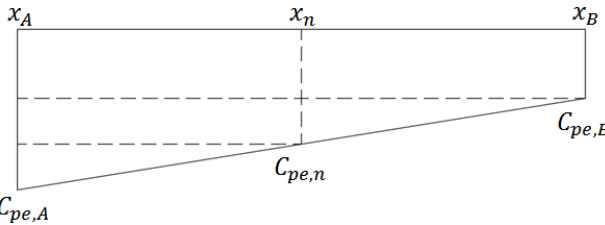
Figure 15. Wind pressure coefficient interpolation scheme.